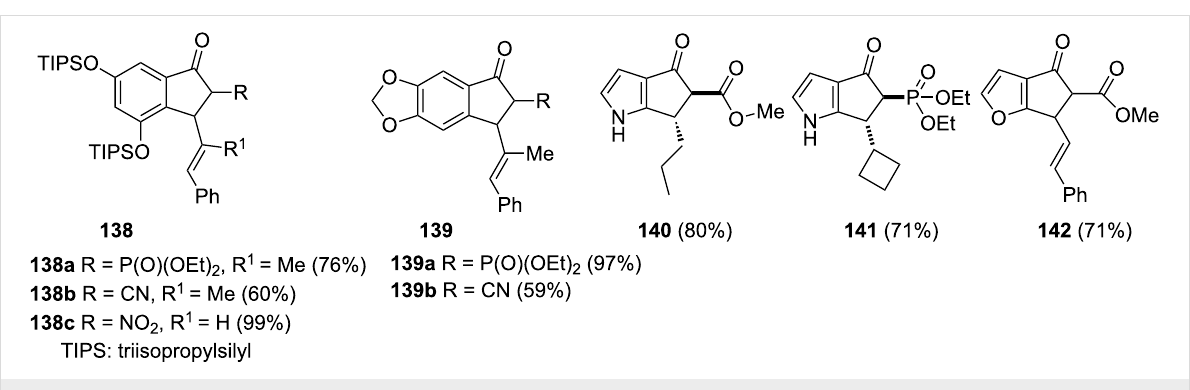
Figure 4: Chemical structures of 1-indanones and their heteroatom analogues 138 – 142